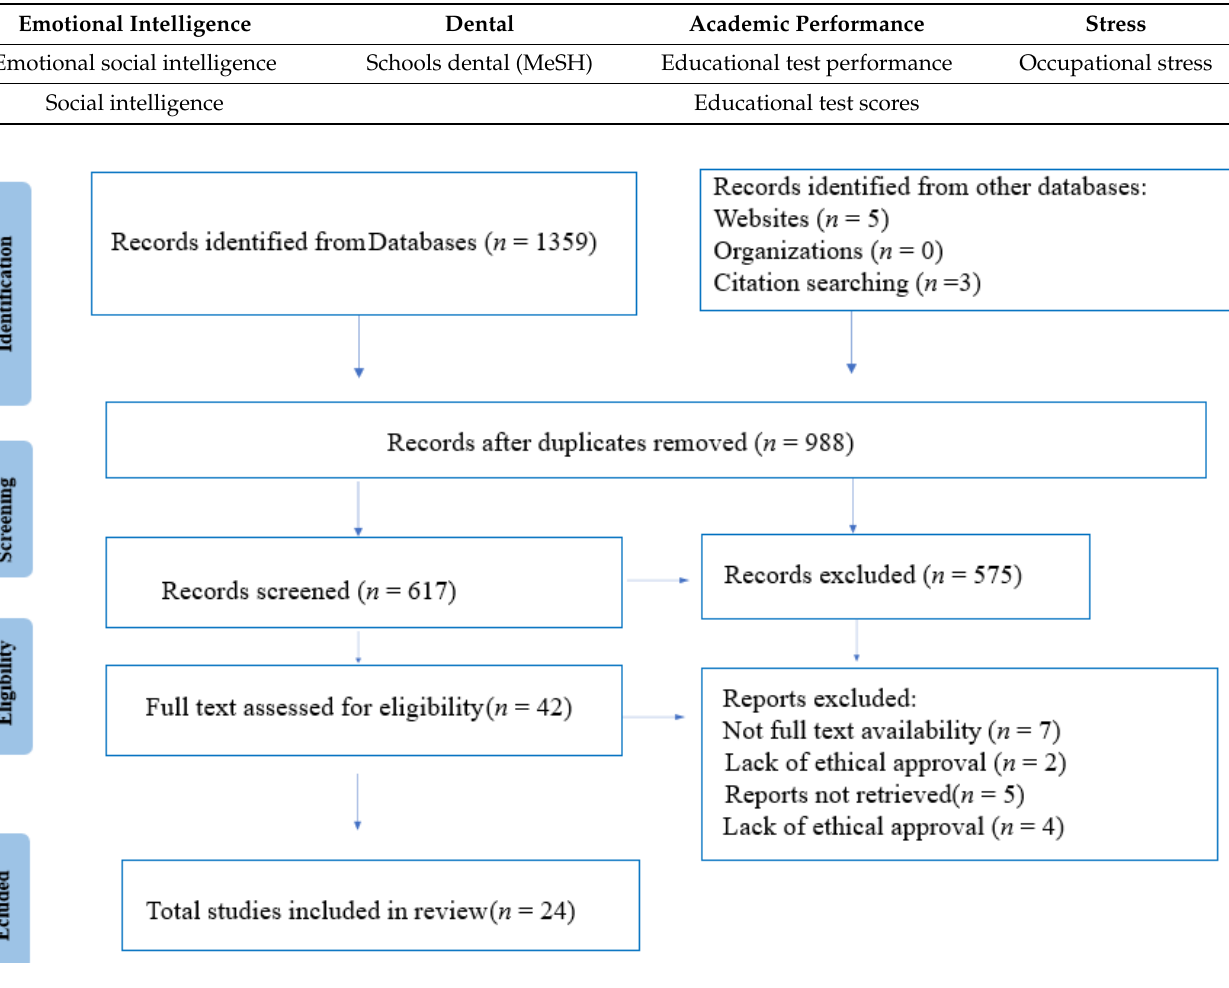
Table 3. Comprehensive database ‐ analysis.